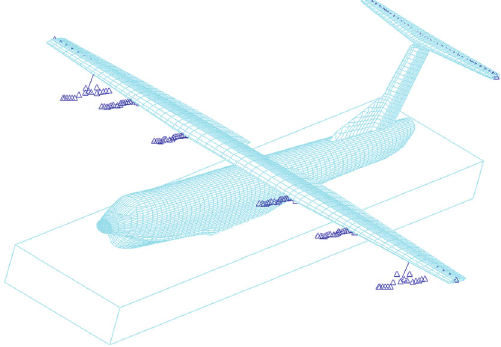
Figure 3: Wet model of large amphibious